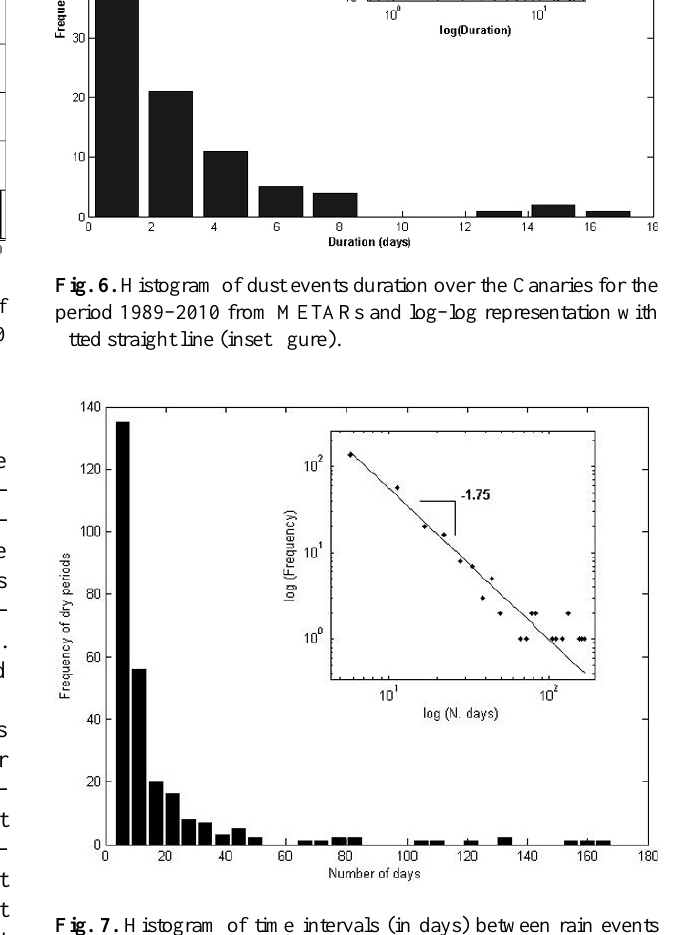
Fig. 7. Histogram of time intervals (in days) between rain events for Gran Canaria airport, METARs (1989–2010), and log–log rep- resentation with fitted straight line (inset